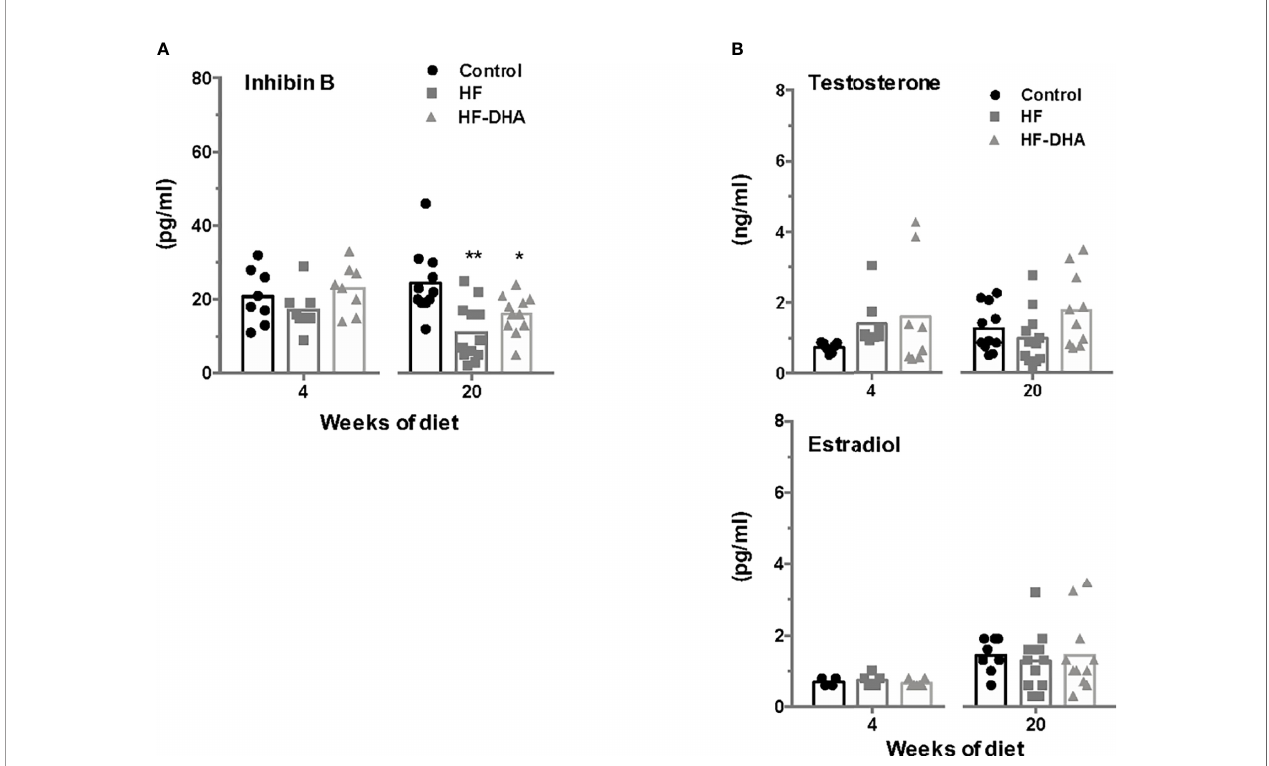
FIGURE 8 | Circulating inhibin B and sex steroid levels in rats after short-term or long-term high-fat diets. Serum levels of inhibin B (A) and sex steroids, testosterone and estradiol (B) were determined after 4 and 20 weeks of diet, as described in Materials and Methods . The bar height re fl ects the mean. Data are expressed as means ± SEM from 7-8 and 10-12 rats for short- and long-term diets, respectively and were analyzed by one-way ANOVA followed by non-parametric one-way ANOVA (Kruskal-Wallis test) followed by Dunnett ’ s multiple comparison test. * P ≤ 0.05; ** P ≤ 0.01 vs